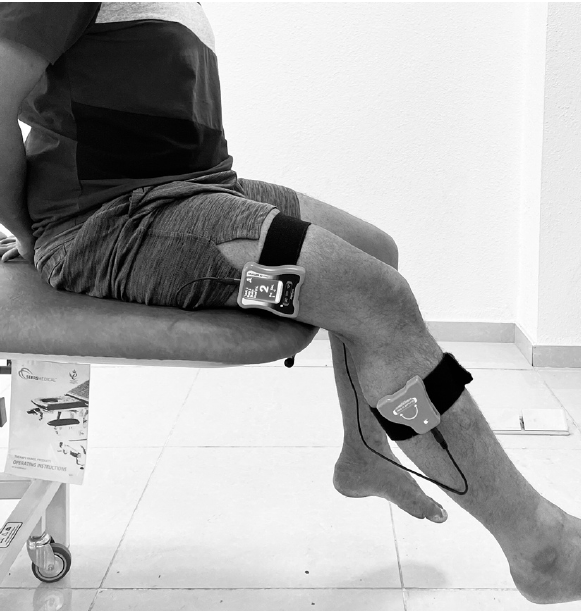
Figure 1. Knee joint position error assessment using a dual digital inclinometer.